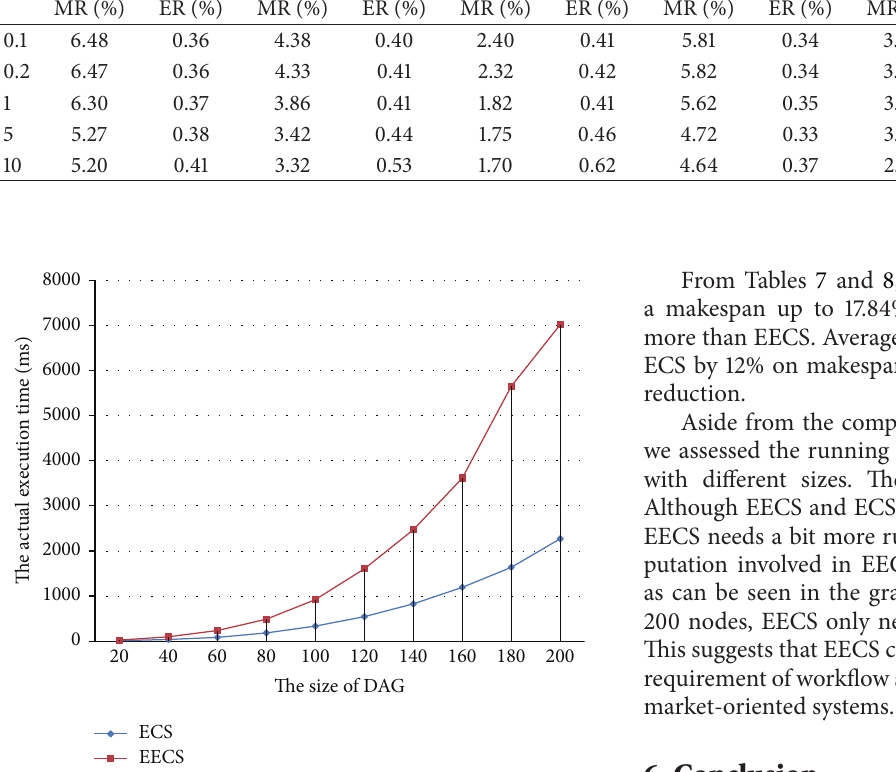
Figure 9: The actual execution time of compared